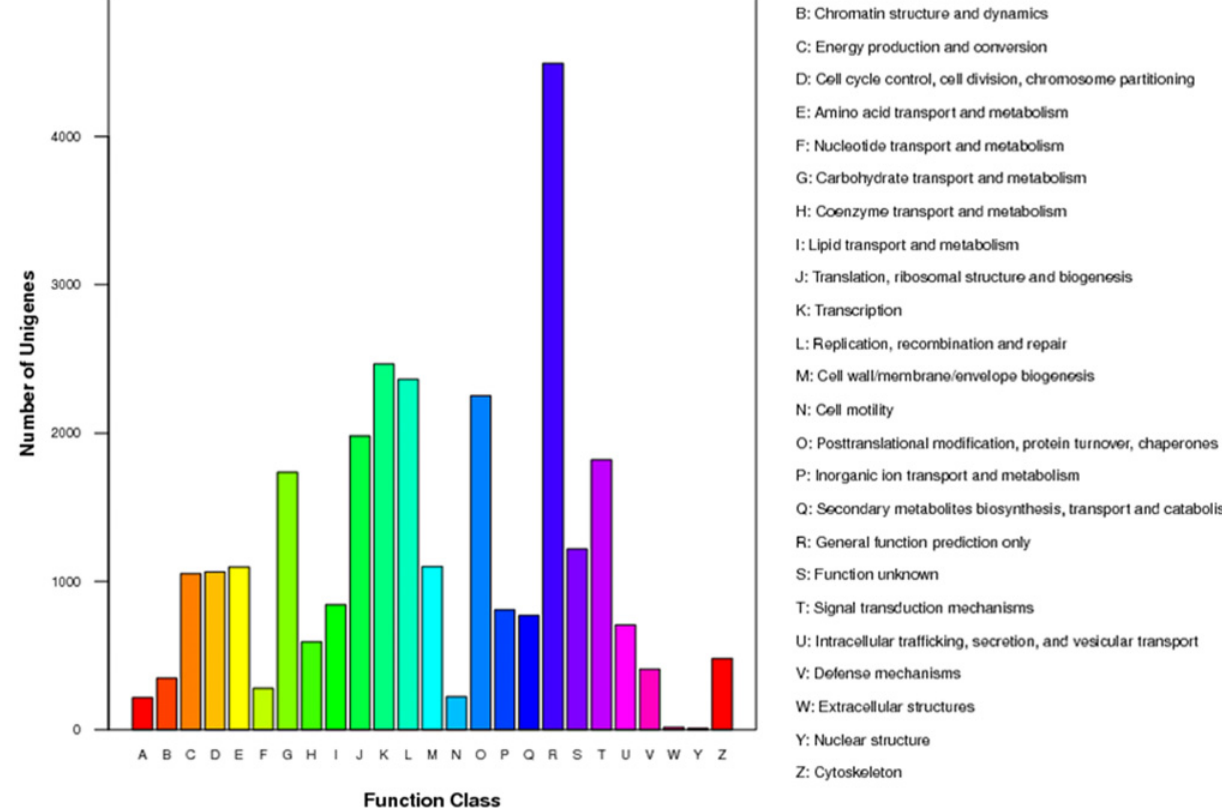
Fig 4. Clusters of orthologous groups (COG) classification of the assembled American ginseng unigenes. A total of 15,552 unigenes were classified into 25 functional categories according to their predicted gene products (COG cut-off E-value was 10 –